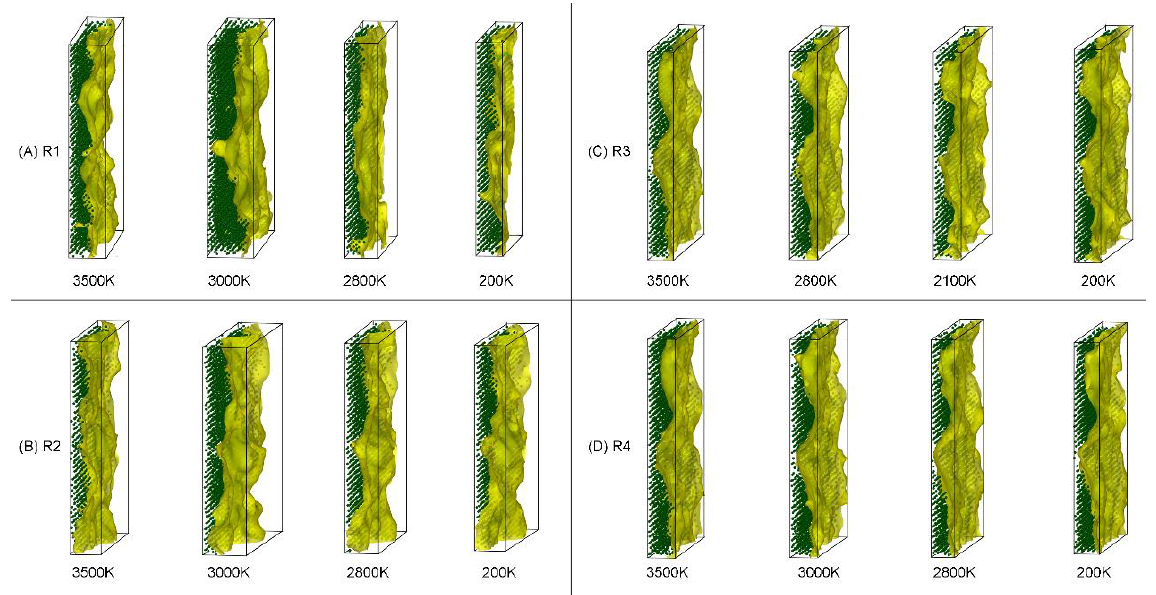
Figure 10. Evolution of solid – liquid interface slices at different cooling rates, R1: 10 10 K/s, R2: 10 11 K/s, R3: 10 12 K/s, R4: 10 13 K/s.